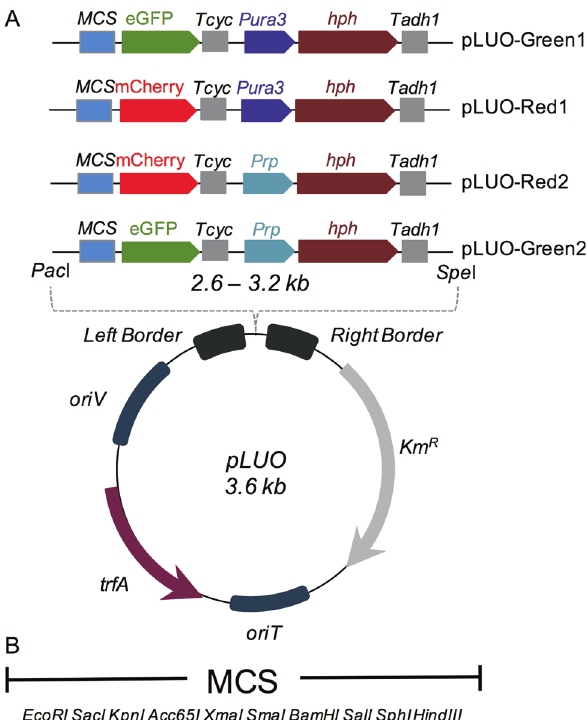
Figure 1 - Representative scheme of the minimal binary vector for fungi transformation through ATMT. (A) Design of the plasmid showing all the minimal modules that compose it, including the four versions of the ex- pression cassette that were constructed. pLUO-Green1 (with eGFP) and pLUO-Red1 (with mCherry) have a Pura3 promoter for hph expression, while pLUO-Green2 and pLUO-Red2 uses Prp2 from T. reesei . (B) Rep- resentation of the restriction enzymes available in the MCS for several cloning options.